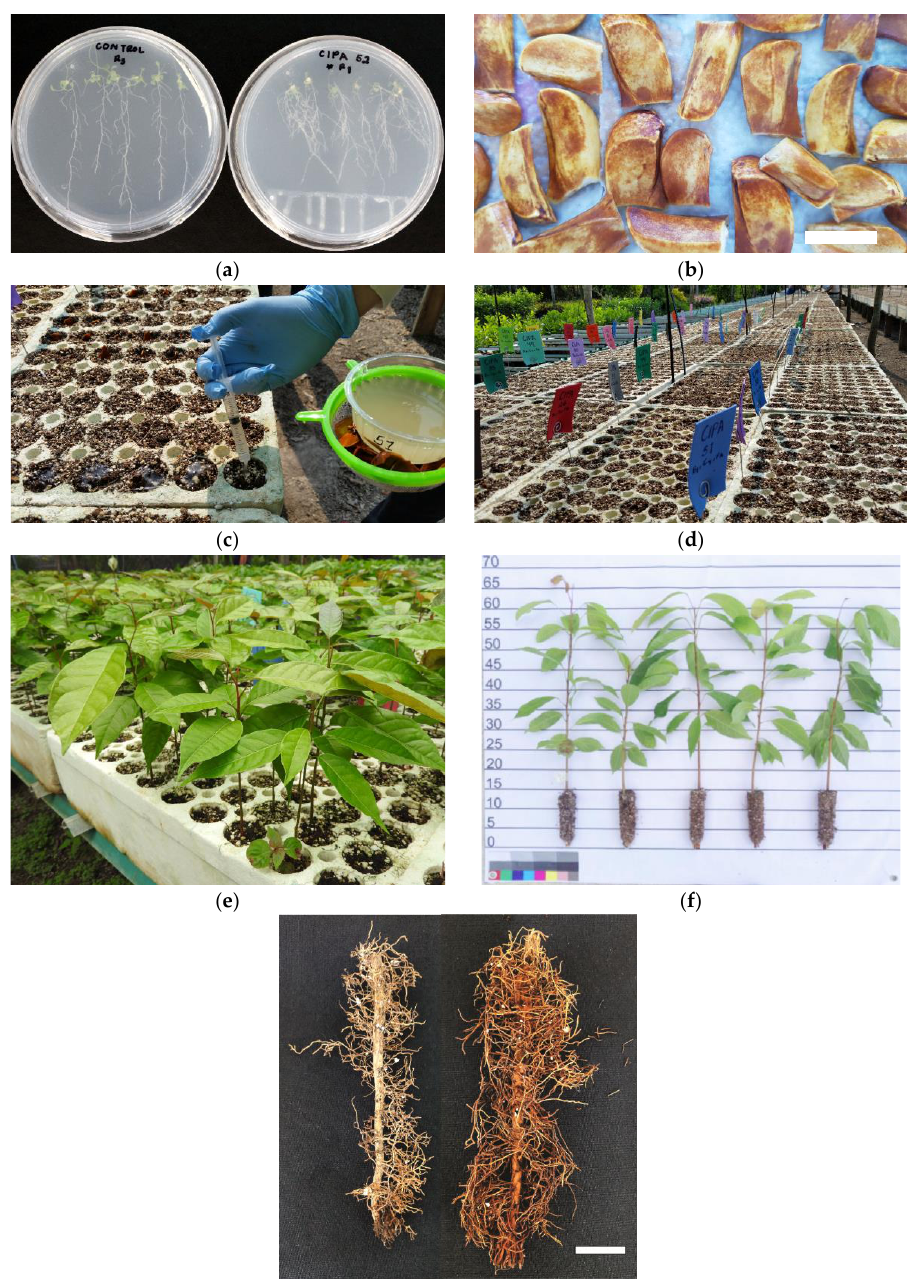
Figure 1. General aspects of key procedures and results. Photographic evidence of ( a ) A, thaliana in vitro assay showing the different phenotypes found in seedlings without rhizobacteria inoculates ( left ), where straight roots with scarce secondary roots are formed in comparison to seedlings growing in the presence of one of the strains used in this work ( right ) B. siamensis (strain-52). ( b ) Surface- disinfected S. macrophylla seeds (see Section 2). The white bar in the bottom-left of the picture corresponds to 1 cm. ( c ) In-nursery re-inoculation of rhizobacteria strains. Notice that at this point, seeds are already covered by the substrate. ( d ) Nursery once established the bioassay within a commercial production process. ( e ) S. macrophylla plants two months after germination growing in the nursery. ( f ) An aspect of plants three months after germination. Scale in the left is expressed in cm. ( g ) Representative dried roots of S. macrophylla plants corresponding to non-inoculated plants ( left ) and plants inoculated with B. siamensis (strain-52) ( right ). The white bar in the bottom-left of the picture corresponds to one